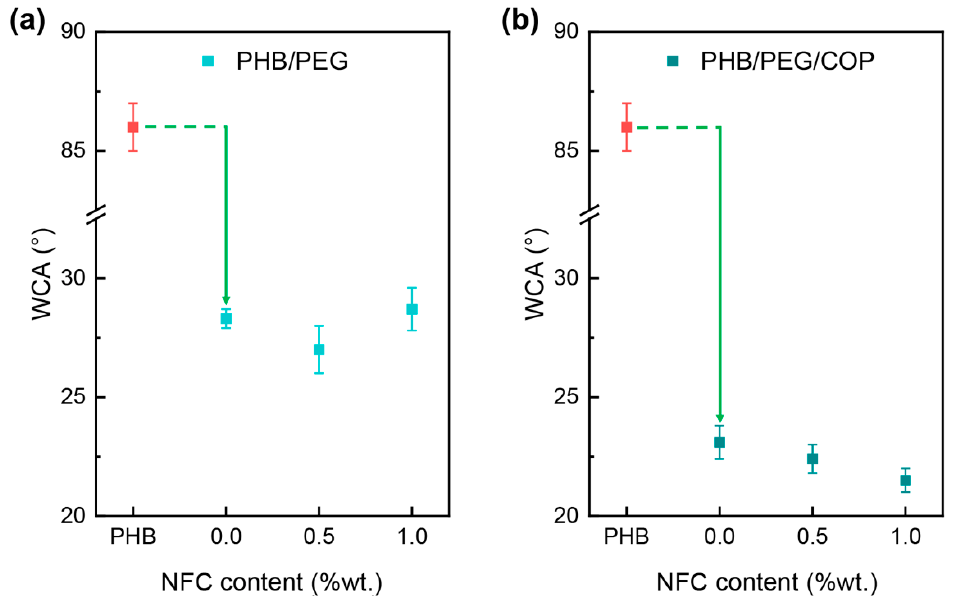
Figure 5. WCA behavior of ( a ) PHB/PEG/NFC and ( b ) PHB/PEG/COP/NFC composites. Green arrows show the WCA decline due to PEG with or without the addition of COP.